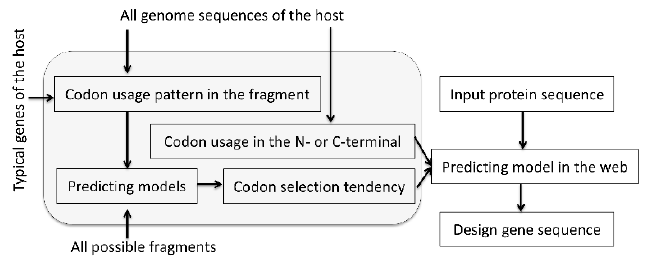
Figure 1. Flowchart summarizing the Presyncodon approach.